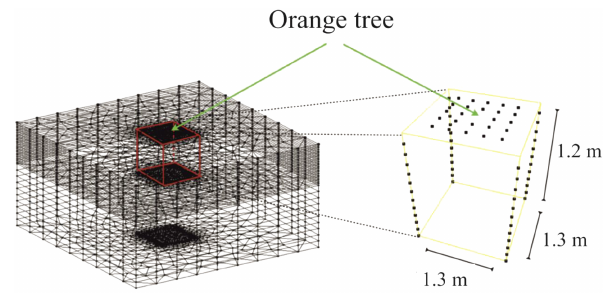
Figure 3. Electrode geometry around the orange tree and 3-D mesh used for ERT inversion.